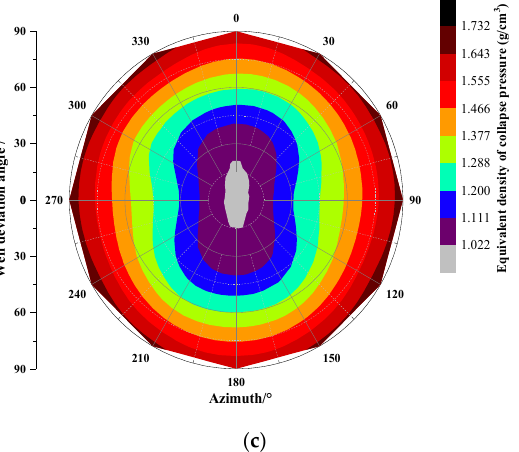
Figure 12. Collapse pressure distribution under different number of structural planes: ( a ) no structural plane; ( b ) one structural plane; ( c ) three structural planes.